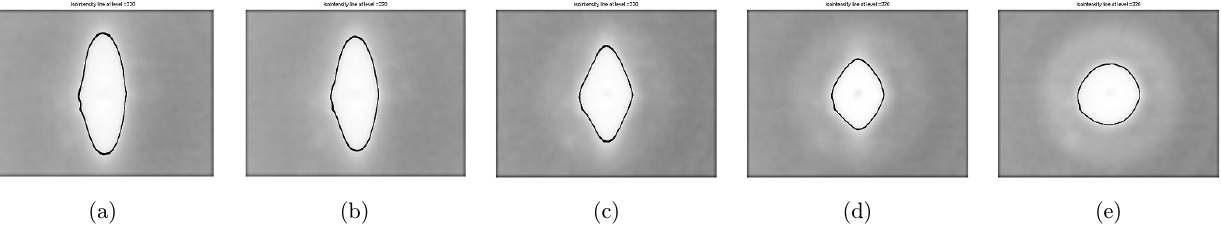
Fig. 5. The isointensity lines corresponding to the di®raction patterns shown in Fig. 4. The level of light intensity is 220 (in units of Fig. 6). Each set of ¯ve isointensity lines is a separate object in our study. All these ¯ve lines are characterized by the same number f 0 meaning a normalized light intensity. The ektacytometer calibration problem is to ¯nd this number. The main idea of our solution to this problem lies in the fact that the energy parameter of the di®raction pattern (number f 0 ) can be expressed in terms of the geometric parameters of the di®raction patterns obtained using specially prepared blood samples. Mathematically, this idea is expressed by the di®ractometric equation